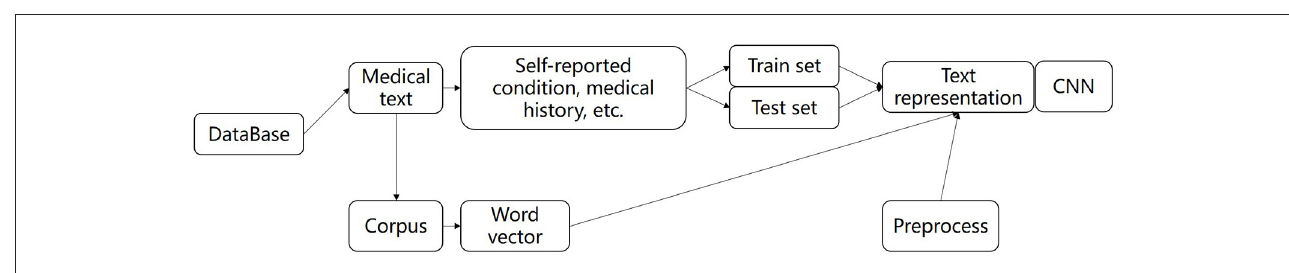
FIGURE2 The flow of text feature